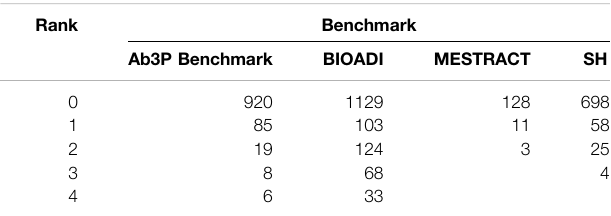
TABLE 7| #correctbyrank(position inn-bestlist).Thetopchoice(rank 0)isoften correct, but there is plenty of room for improvement since there are correct candidates in ranks 1 – 4.